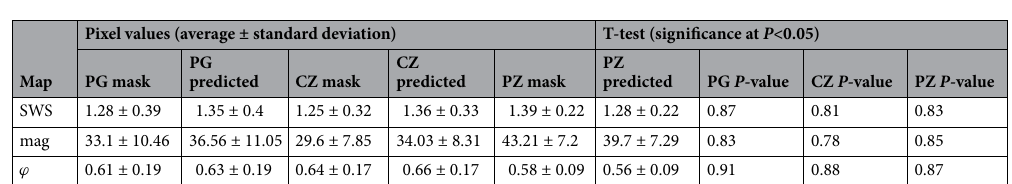
Table 4. Values obtained in PG, CZ and PZ regions of interest using ground truth and predicted masks. “mask” and “predicted” in the column headers refer to the ground truth and model output, respectively. T-test results between ground truth and predicted masks for PG, CZ, and PZ are reported in the right part of the table (based on segmentation results for the IMs using magnitude images as input).